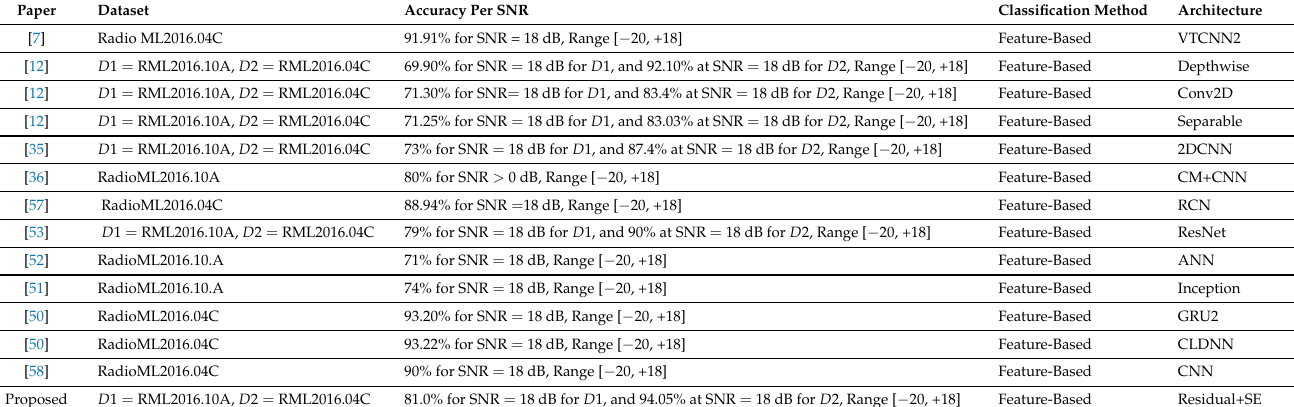
Table 5. Comparison of accuracy attained for both RML datasets on various architecture configura-